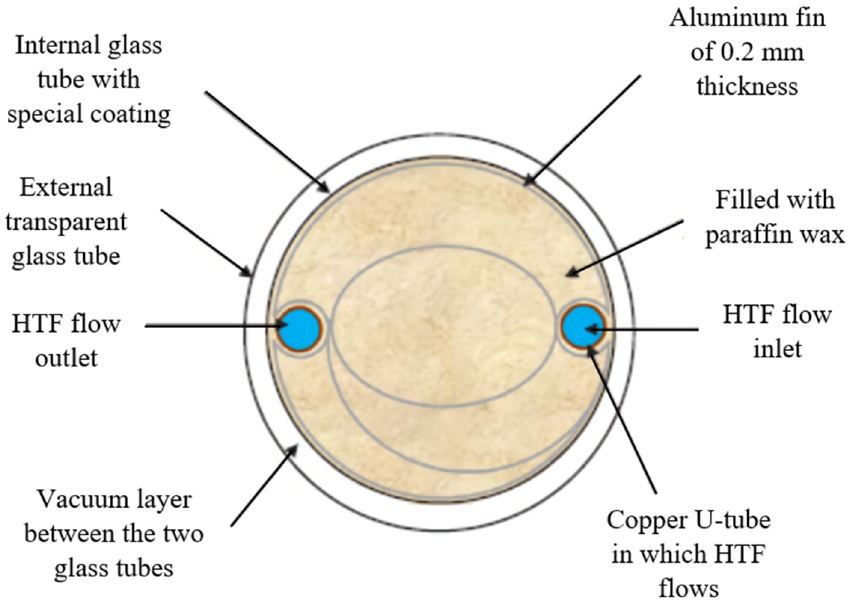
Figure 14. Integration of PCM (paraffin wax) inside of a U-type ETC. Adapted with permission from ref. [126] 2018 Essa et al.